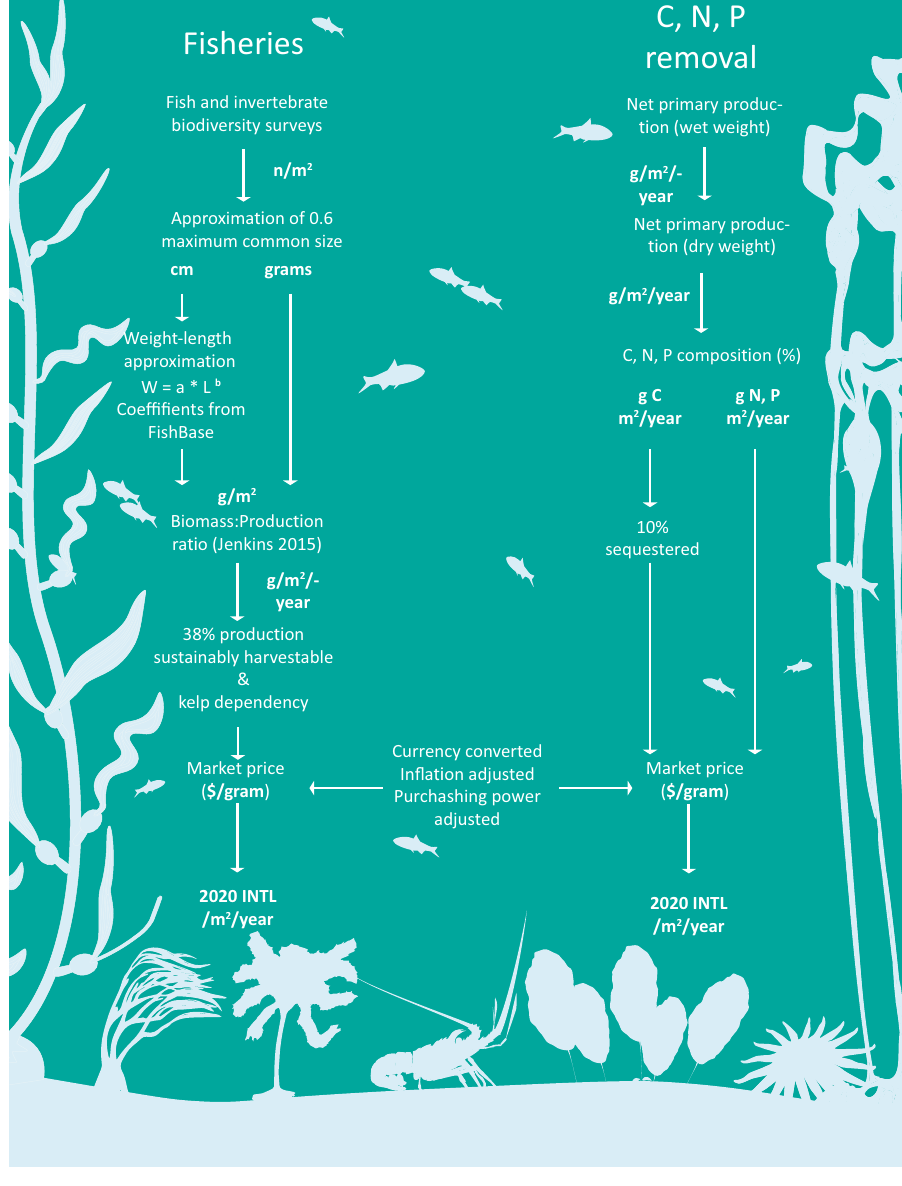
Fig.5|Flowchartofstepsforcalculatingthemarketvalueofdifferentservices. Diagram of the data processing steps used to translate ecological values into economic ones. In weight-length approximation, W=weight, L=length, a & b =